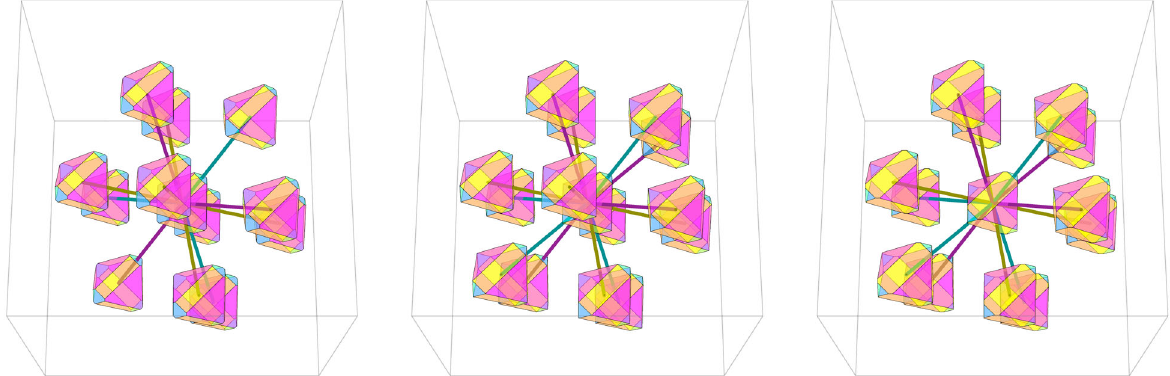
FIG. 2 Example of Minkowski lattice types G 6 − , G 7 þ , and G 6 þ (left to right) for a noncentrally symmetric polyhedron. Lines connect the reference polyhedron at the origin to its neighbors ’ centers. The lines indicate the color of the faces of the reference polyhedron that touches the neighboring polyhedra. The lines are darker shades of {magenta, cyan, and yellow} to aid the eye. The packings correspond to the 323 · 1 -family region ρ 4 , the ridge ρ 4 ∧ ρ 0 , and the region ρ 0 (left to